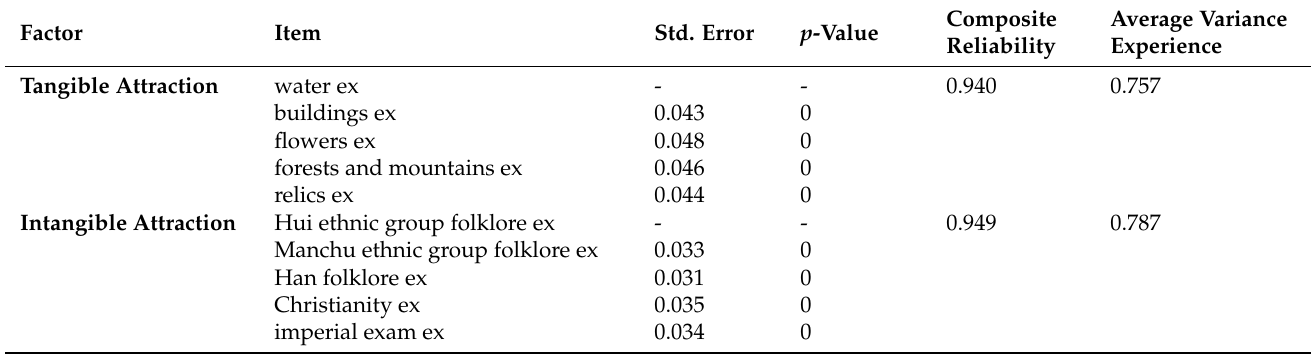
Table 5. CFA of experience